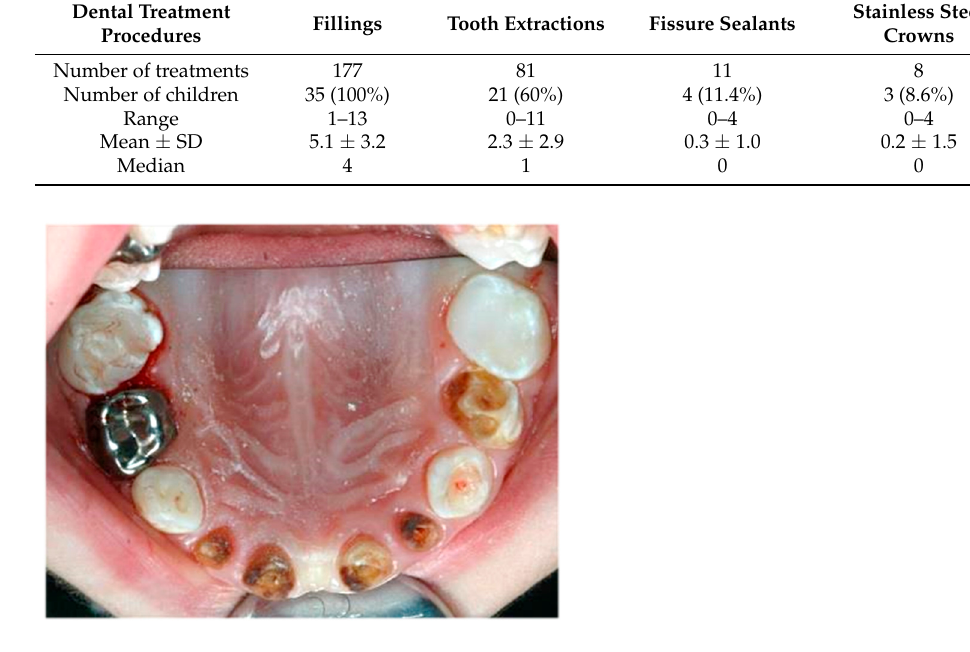
Figure 3. Severe early childhood caries in the primary maxillary teeth of a child requiring several types of dental treatment under general anaesthesia.